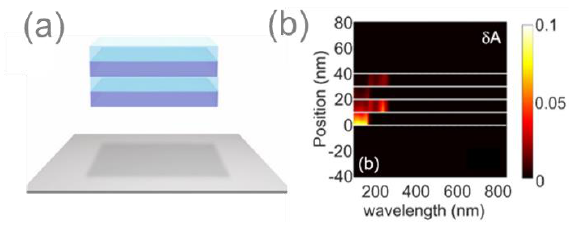
Fig. 1. (a) Schematics of a multilayer structure made of SiO 2 and PS slab bilayers, immersed in glycerol over a Si substrate. (b) Spectral and spatial distribution of absorption per unit volume, δA , of a representative example of a multilayer made of 2 bilayers. The specific geometrical parameters are: nanostructures comprising 50% SiO 2 and 50% PS, with a total thickness of 40 nm distributed in 2 bilayers (i.e., each layer thickness corresponds to 10 nm), immersed in glycerol with the SiO 2 layer facing a Si wall. As a guide for the eye, limits of each material layer of 10 nm thickness are shown with horizontal lines.